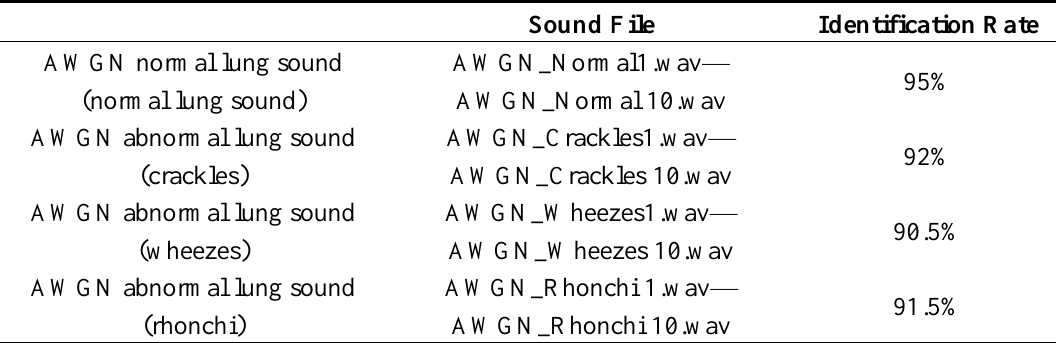
Table 6. 20 dB white Gaussian noise with normal and abnormal lung